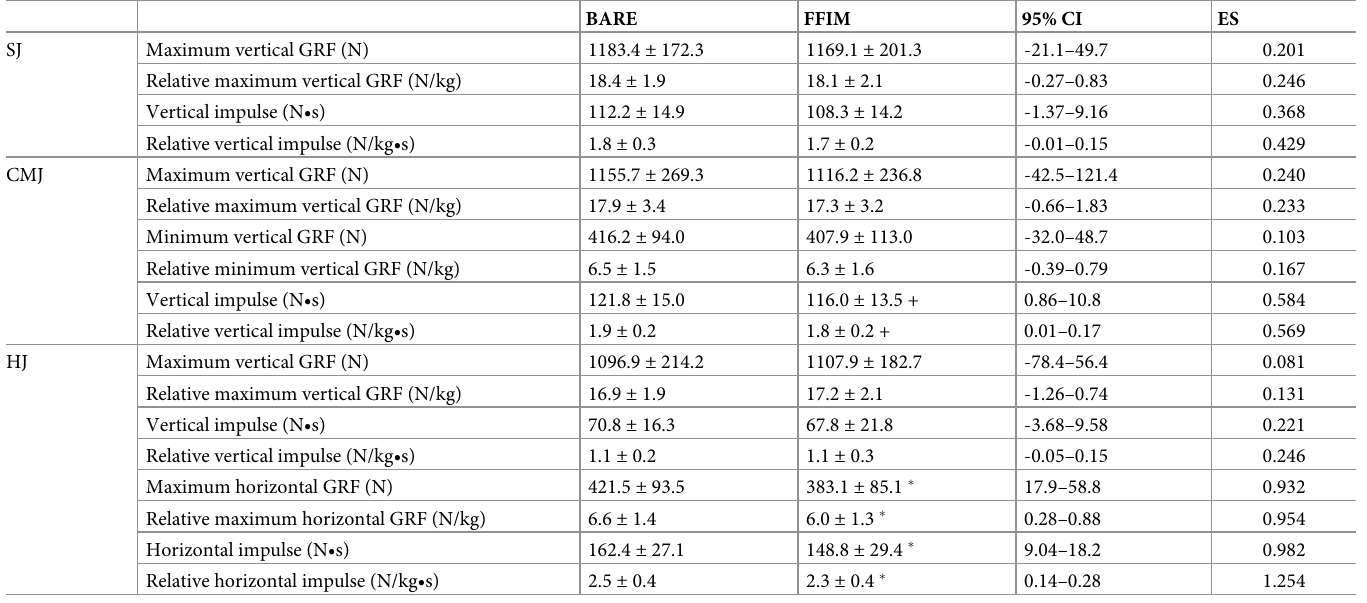
Table 2. Comparison of ground reaction force (GRF) related variables during the take-off phase of the squat jump (SJ), countermovement jump (CMJ) and hori- zontal jump (HJ) under barefoot (BARE) and forefoot immobilization (FFIM) conditions.